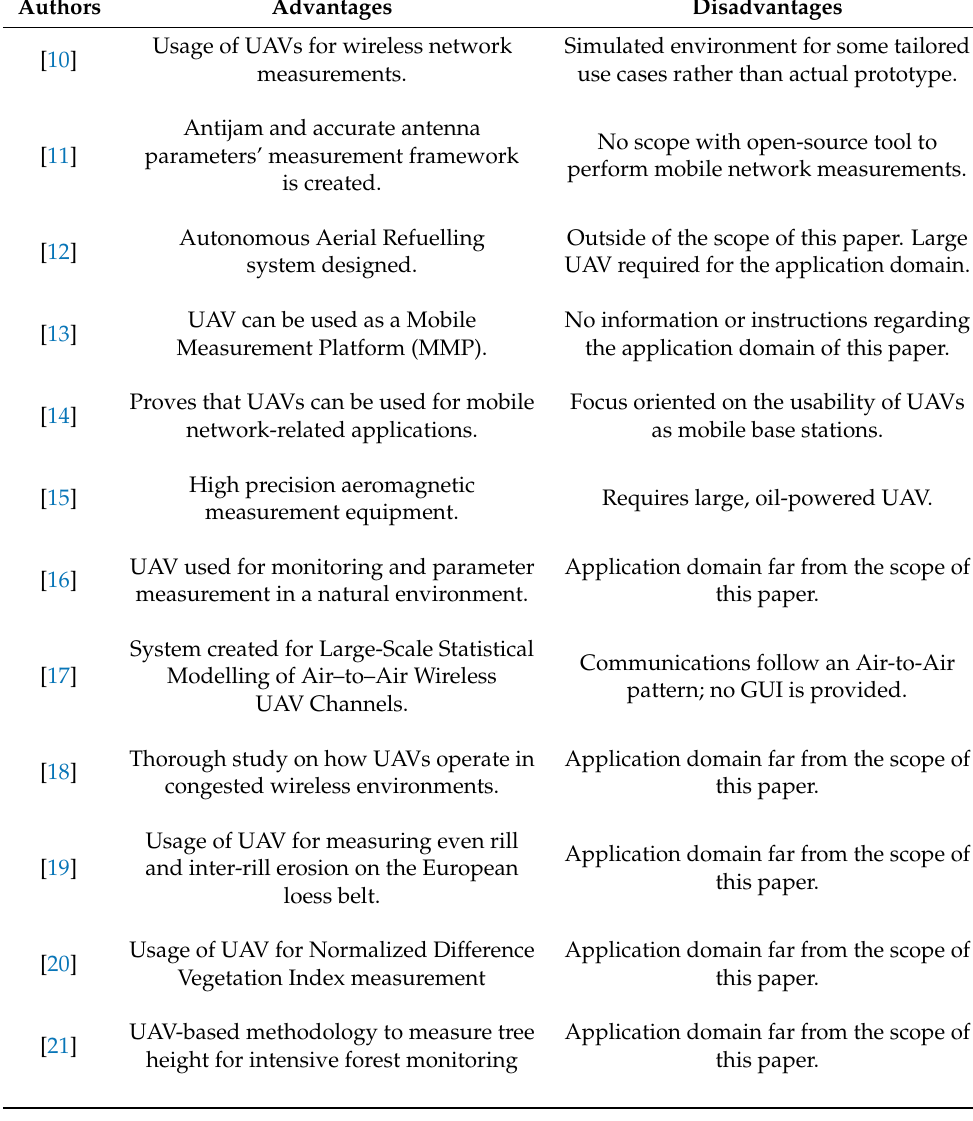
Table 1. Advantages and disadvantages shown in the studied UAV-based applications.